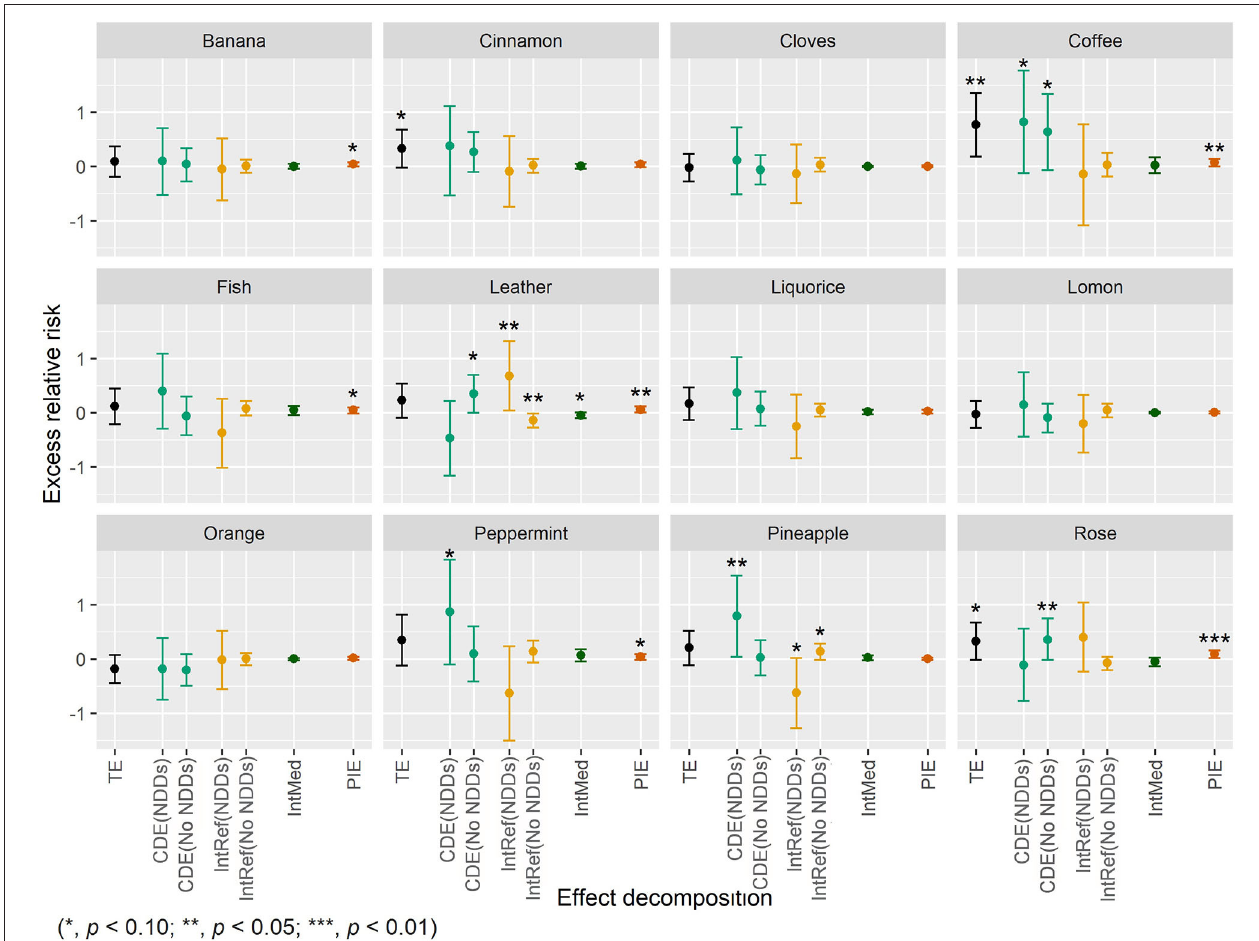
FIGURE 3 | The four-way decomposition method of excess relative risk of mortality for individual